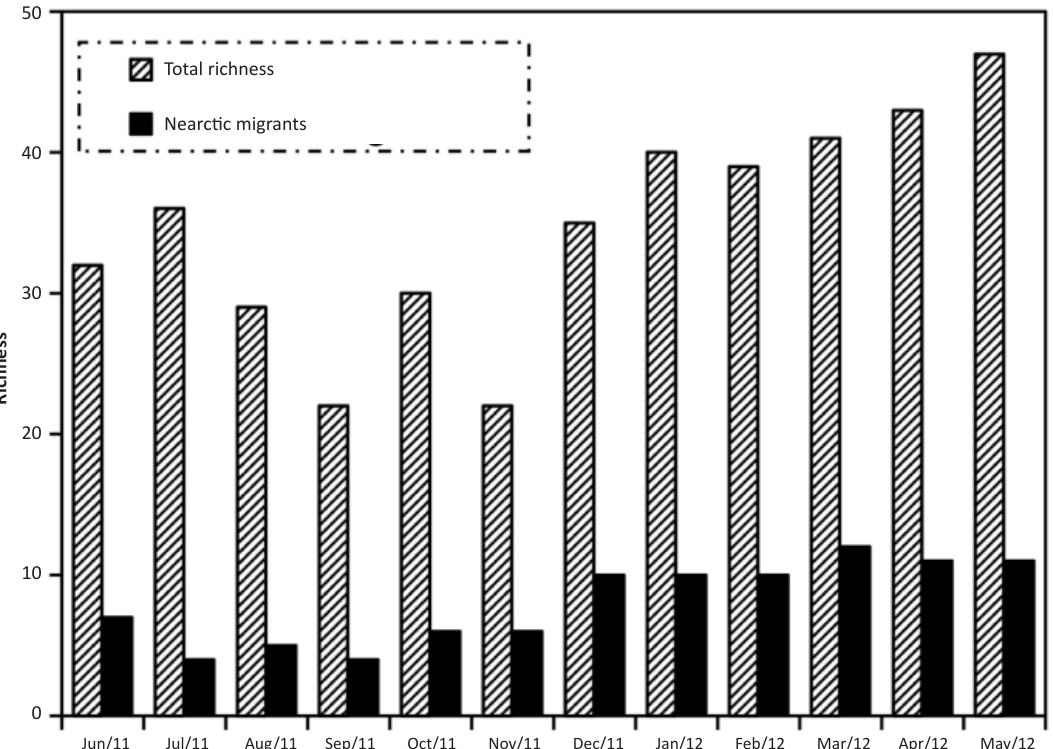
Figure 2. Monthly richness of waterbird assemblages on the coastal area of Quissamã municipality, northern coast of Rio de Janeiro State, Brazil, between June 2011 and May 2012.